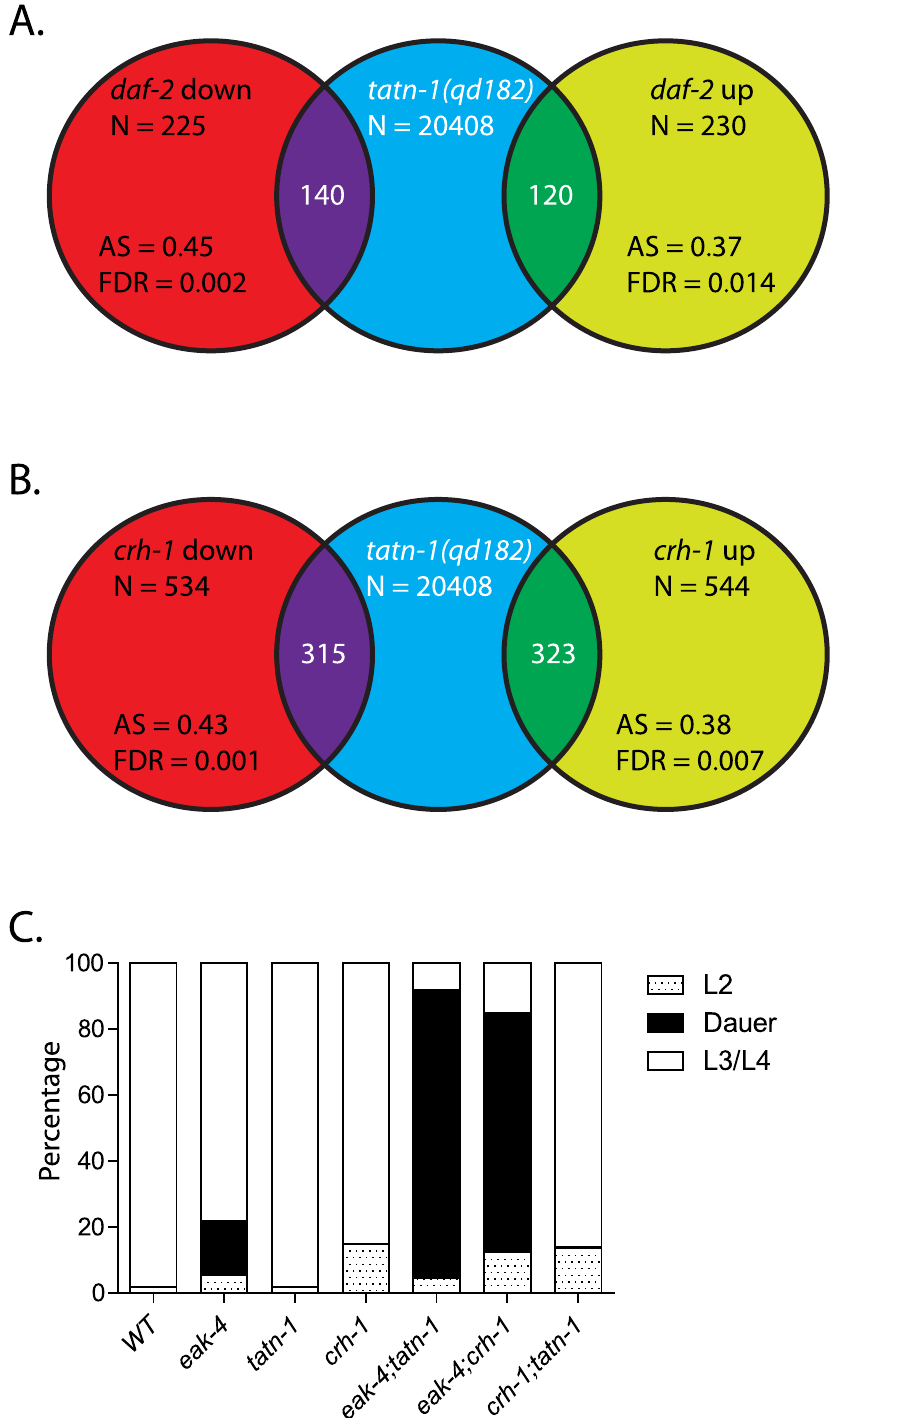
Figure 7. tatn-1 mutants and crh-1 /CREB mutants share gene expression profiles and effects on dauer formation. (A) Shot-gun whole transcriptome sequencing (RNA seq) was used to used to characterize and measure the transcriptome of N2 and tatn-1(qd182) mutants. From these experiments a total of 20,408 mRNA and other RNA transcripts were detected. To test for evidence of a daf-16 /FOXO gene expression signature in the tatn-1(qd182) mutants Gene Set Association Analysis (GSAA) was used to determine whether the expression of daf-16 /FOXO target genes regulated in the context of daf-2/ IGFR signaling are associated with the tatn-1(qd182) mutant gene expression profile. GSAA calculates a differential expression score for each gene in the entire 20,408 gene RNA-seq dataset, and then uses a running weighted Kolmogorov-Smirnov test to examine association of an entire gene set with each phenotypic class. The strength of the association is measured by the association score (AS) where positive scores indicate association of the gene set with the phenotype, and statistical significance is measured by a false discovery rate (FDR) that is adjusted for multiple testing. From 225 genes down-regulated in daf-2 /IGFR mutants, 140 showed association with the tatn-1(qd182) profile, and from 230 genes up-regulated in daf-2 /IGFR mutants, 120 showed evidence of association by GSAA analysis. AS represents the association score with positive values